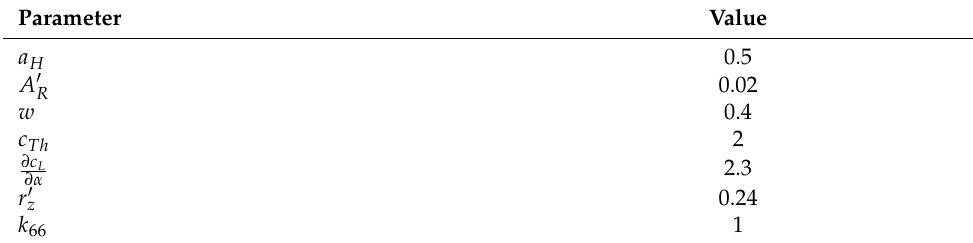
Table 3. Recommended (rough) values of dimensionless parameters in b 2 formula.